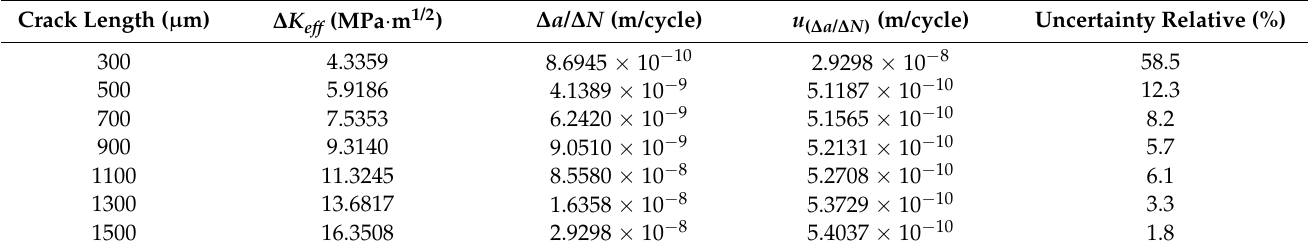
Table 3. Uncertainty on the FCGR for different crack lengths based on the obtained results from d 1 .